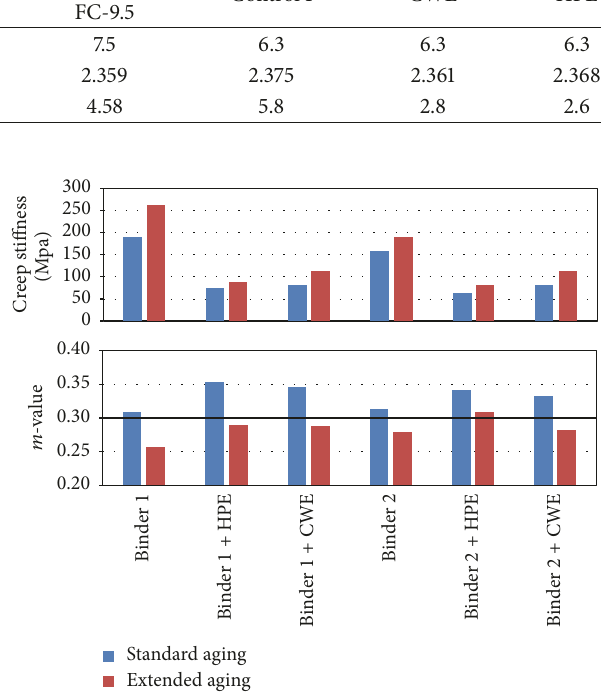
Figure 3: Creep stiffness and m -values of binders at 12 ∘